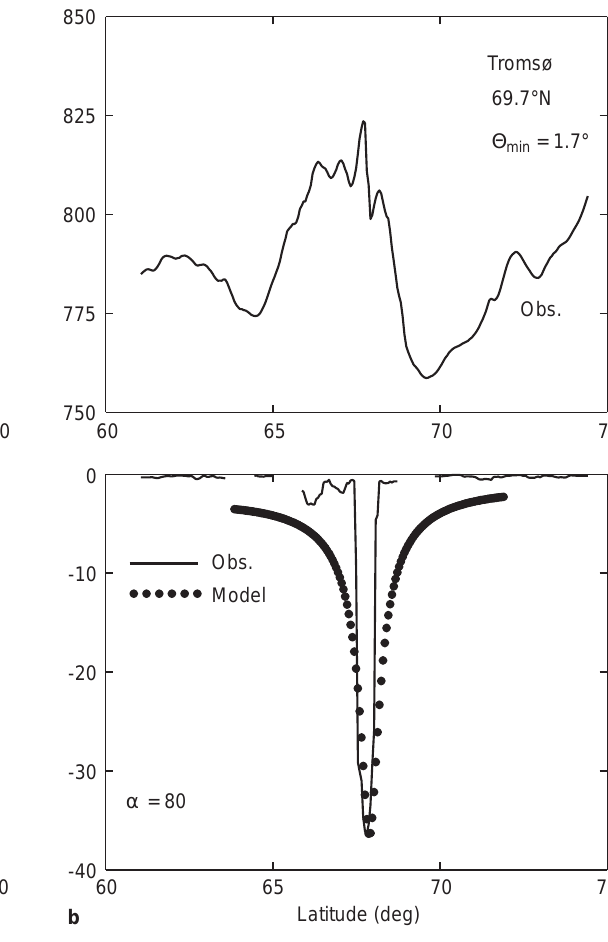
( H min is small), and therefore the spectrum is assumed to be Fig. 2. Examples for phase ( top panels ) and v ( bottom panels ) from e two satellite passages at Troms ( continuous lines ) together with results symmetric around the geomagnetic field direction in theoretical fits. of theoretical fits to the amplitude data ( dots ). The horizontal axis The assumed spectral shape is a power law with a power index 11/3, indicates the geographical latitude of the satellite. In these cases the The best values of a are indicated in the bottom satellite flies close to the geomagnetic meridional plane of the receiver